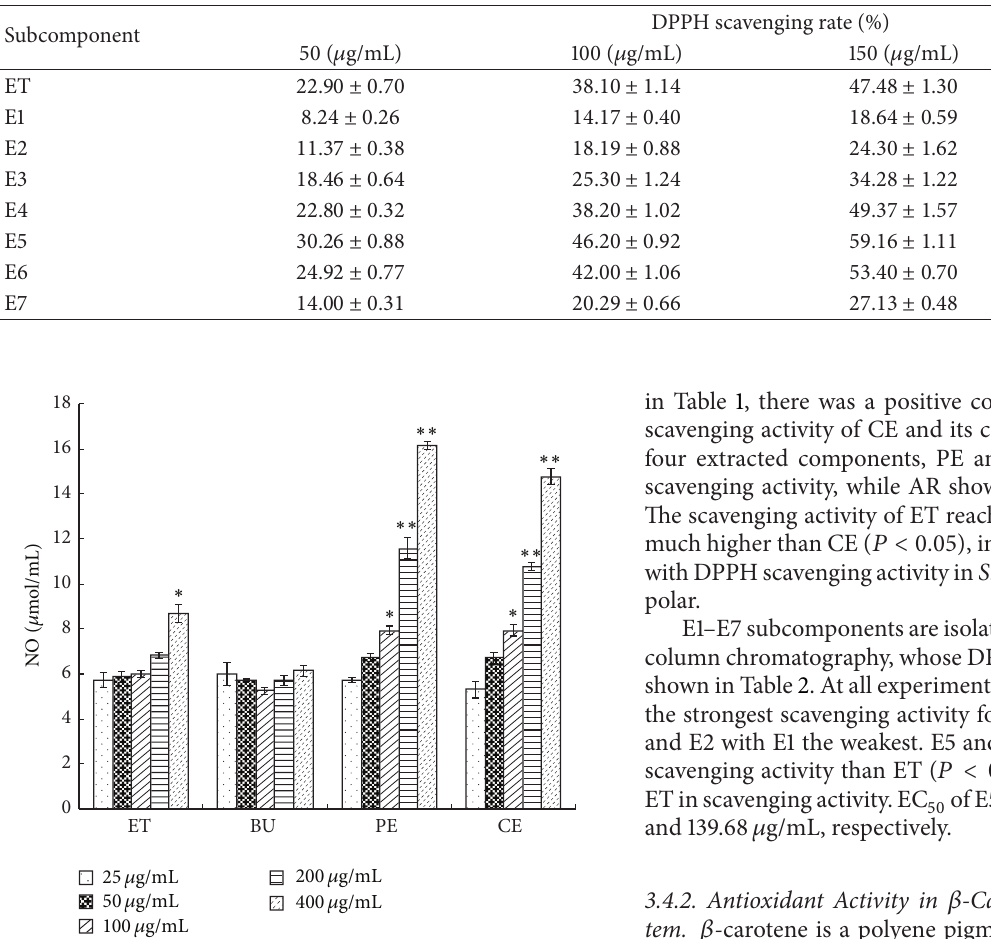
Table 2: DPPH scavenging activity of subcomponents E1–E7 isolated from ET of S. clava .